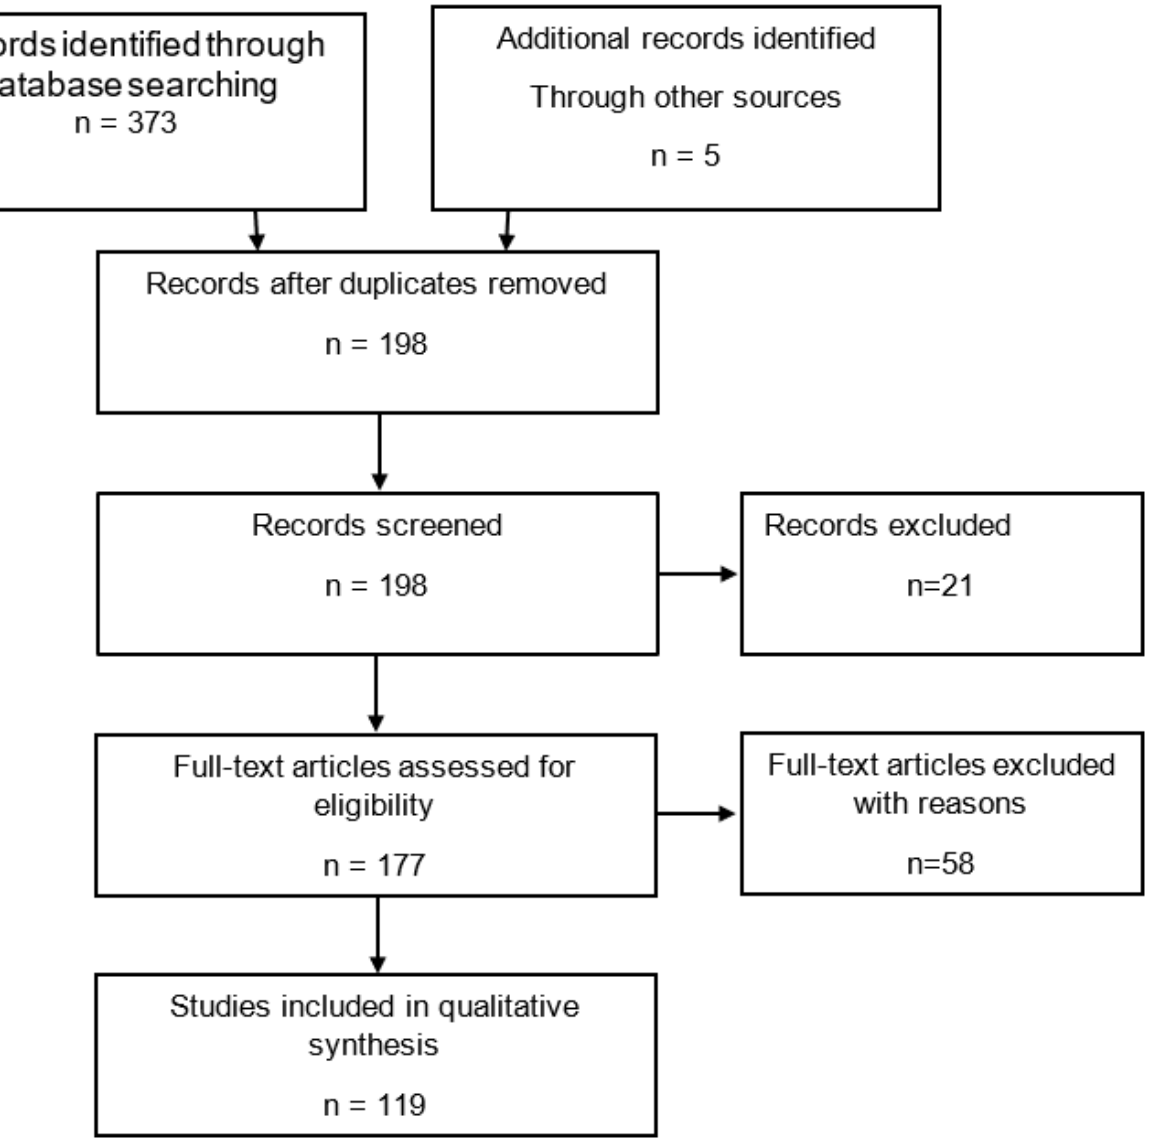
Figure A1. PRISMA flow algorithm; search of databases: PubMed, Scopus, Web of Science. Keywords: in vitro, encrustation, artificial urine, ureteral, urethral, stent, catheter, in combination with Boolean operators; time period until 2021. Exclusion criteria: non-relevant, non-English articles, no abstract available,